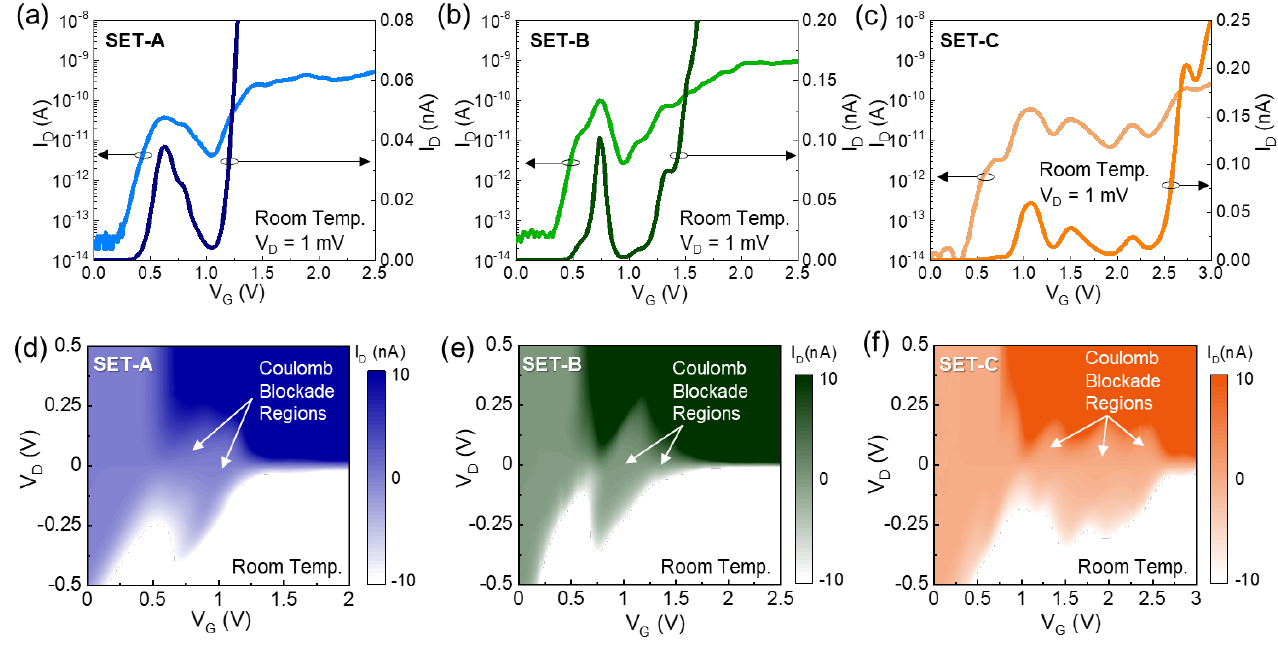
Figure 2. Transfer characteristic curves (i.e., I D – V G at V D = 1 mV) at room temperature of ( a ) SET-A, ( b ) SET-B, and ( c ) SET-C; and contour plots of I D as functions of V G and V D at room temperature for ( d ) SET-A, ( e ) SET-B, and ( f ) SET-C.